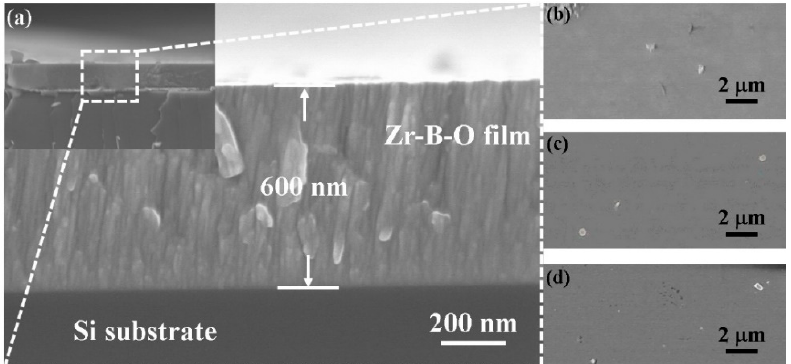
Figure 2. Cross-sectional SEM image of ( a ) nanocomposite Zr-B-O film and top view SEM images of ( b ) ZrO 2 , ( c ) ZrB 2 , and ( d ) Zr-B-O films.